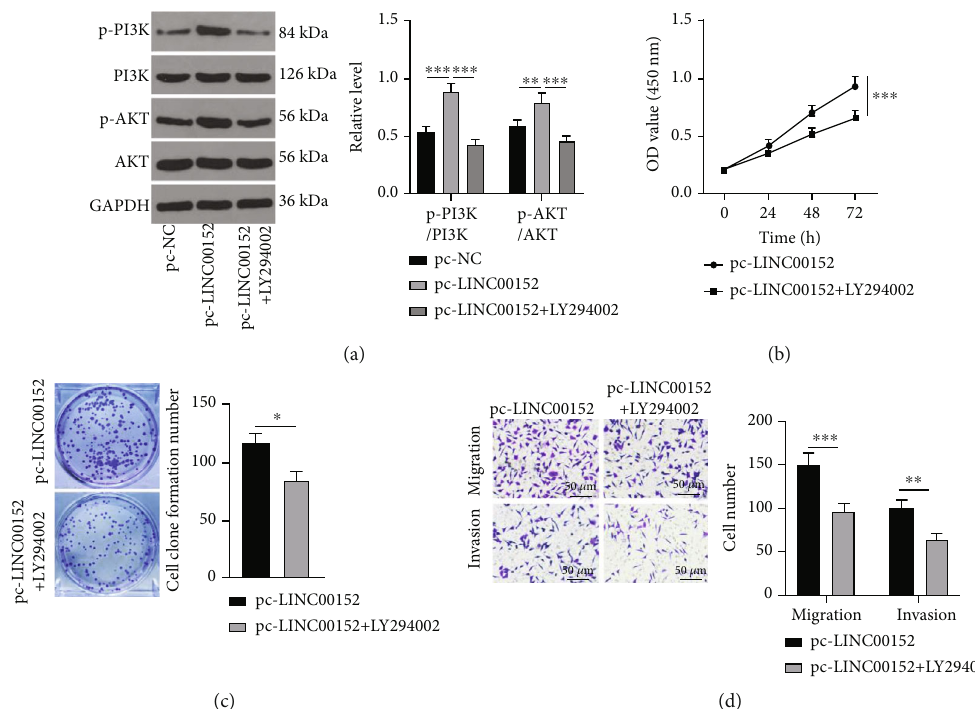
Figure 4: LINC00152 regulates PTC cell growth and invasion via the PI3K/AKT axis. Initially, 10 μ M LY294002 was added into IHH-4 cells to conduct pretreatment for 2h. (a) Levels of the PI3K/AKT axis-related proteins (PI3K, p-PI3K, AKT, and p-AKT) veri fi ed through Western blot analysis. (b, c) Cell proliferation detected by (b) CCK-8 and (c) colony formation assay. (d) Cell migration and invasion measured through Transwell assay. Repetitions = 3 . Data are expressed as mean ± standard deviation . The t -test was used for pairwise comparison. One-way ANOVA was used to determine statistical signi fi cance. Tukey ’ s multiple comparisons test was applied for post hoc